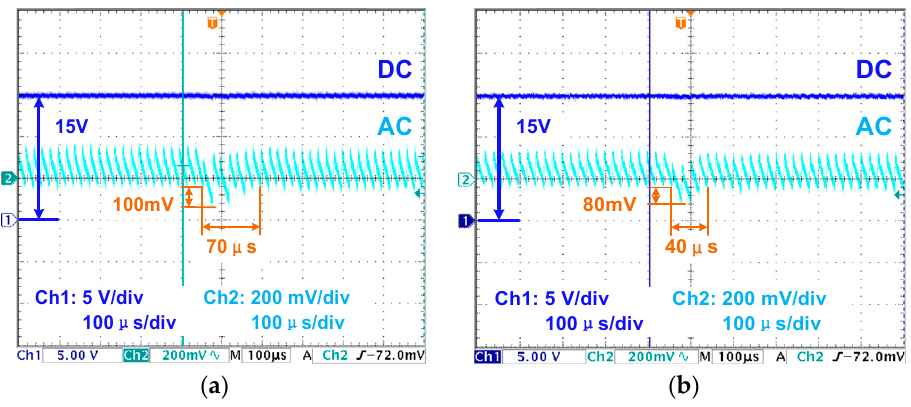
Figure 16. Output voltages when v g steps from 10 V to 7.5 V. ( a ) SCB controller, ( b ) OSCB controller.